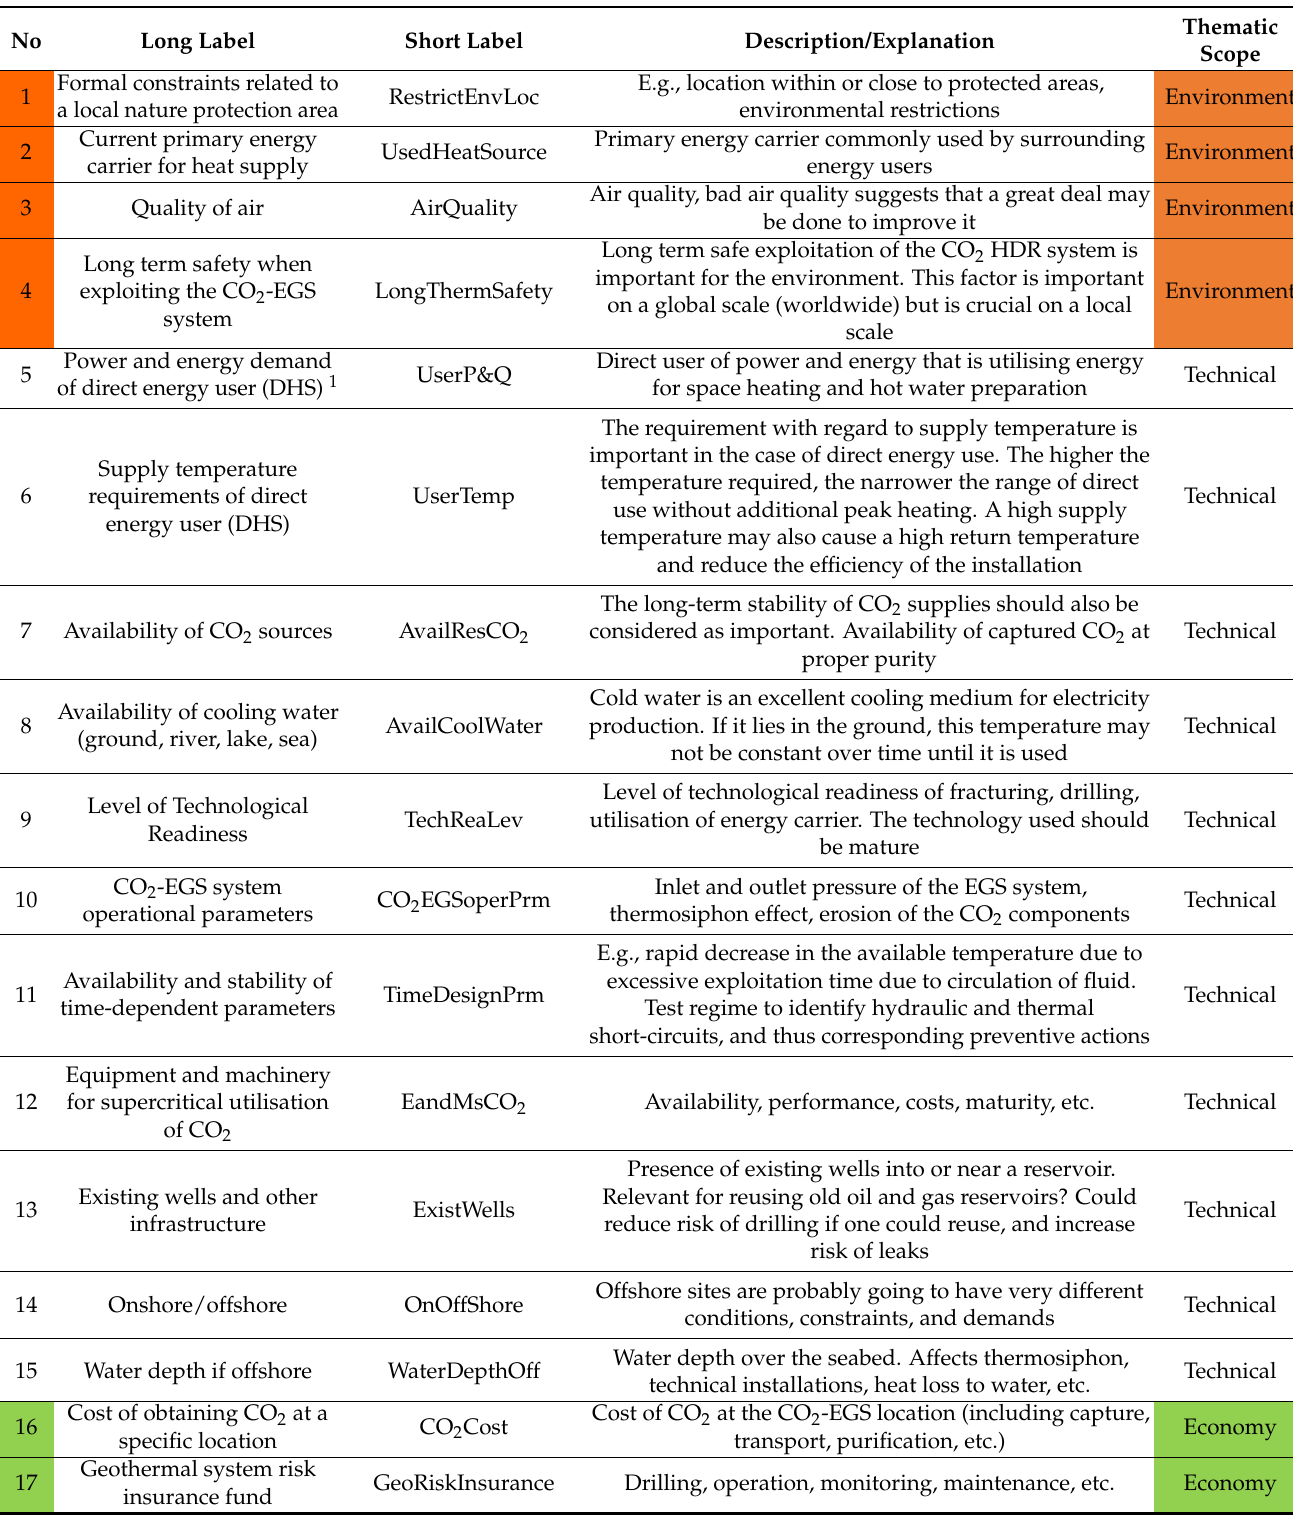
Table A1. List of important variables indicated by the expert group for CO 2 -EGS technology including variables description and additional